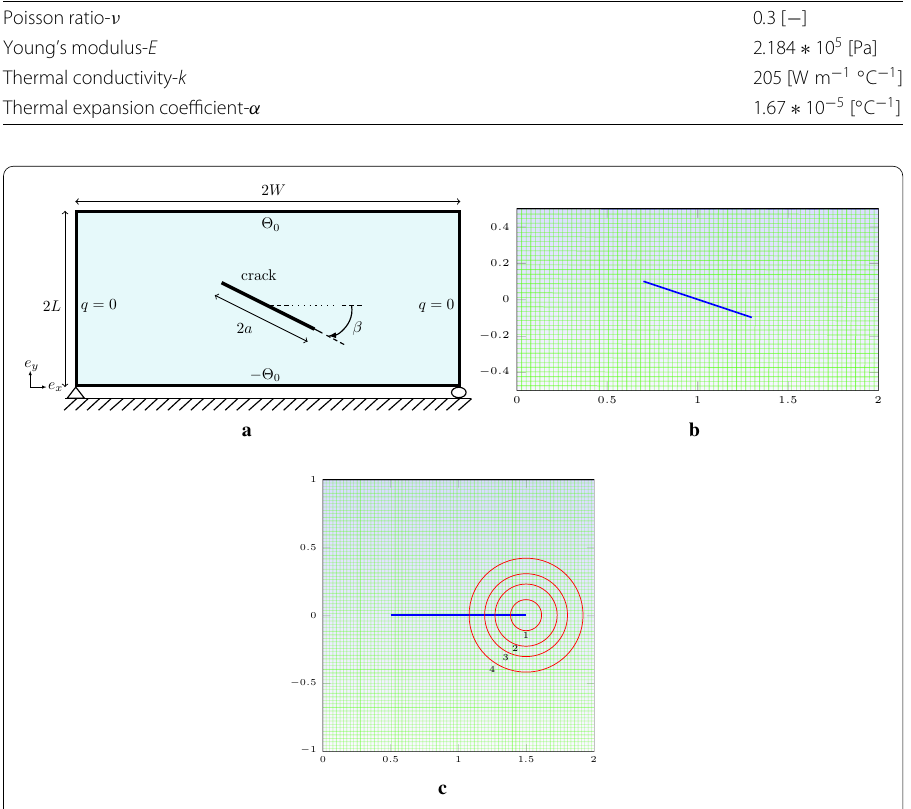
Fig. 4 Rectangular plate with a slope crack: a thermo-mechanical boundary conditions, b structured mesh used for the computation, c J-integral paths used for a square plate with a centred crack